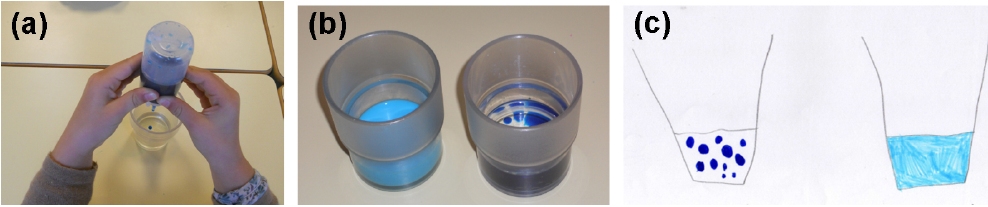
Figure 1. Illustration of the fact that water and oil are not miscible. (a) Adding colored water drops with a pipette in a glass of oil. (b) Outcome of the experiment with milk (left) or oil (right). (c) Child drawing